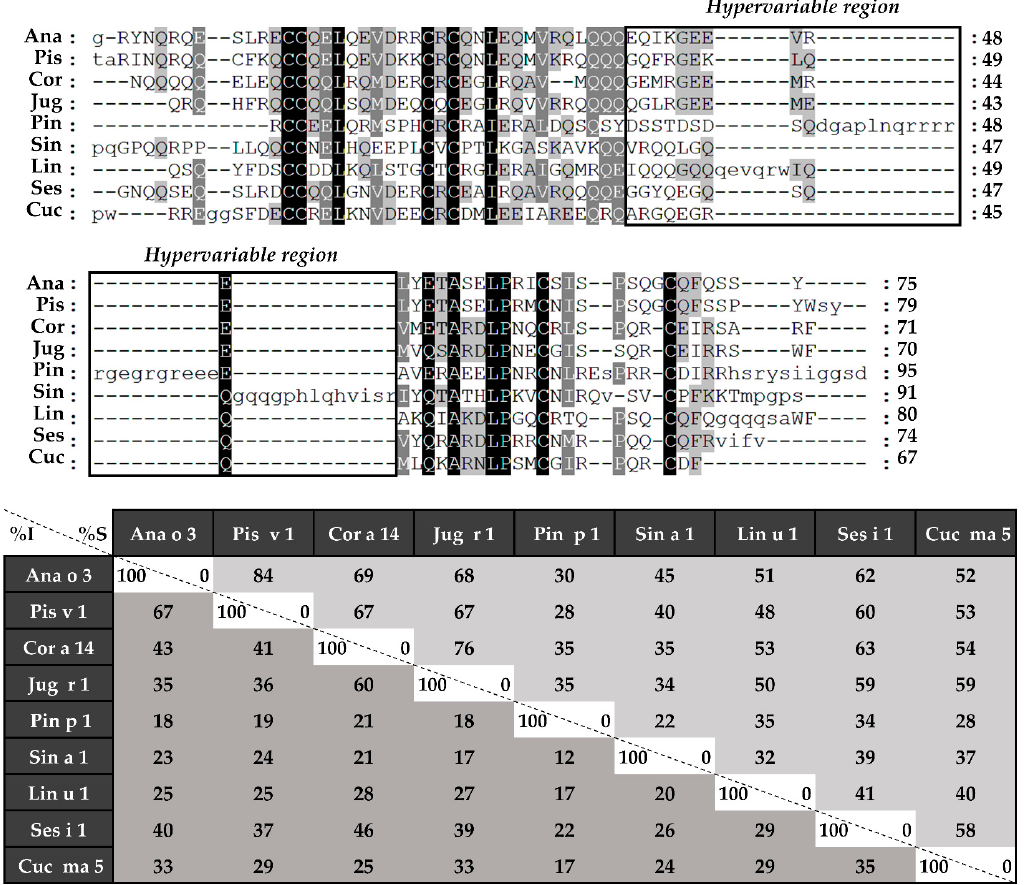
Figure 6. Amino acid sequence alignment of isolated 2S albumins heavy chains. The table under alignment shows percentages of identity (% I, dark grey) and similarity (% S, light grey). Continuous line boxes indicate the hypervariable region .